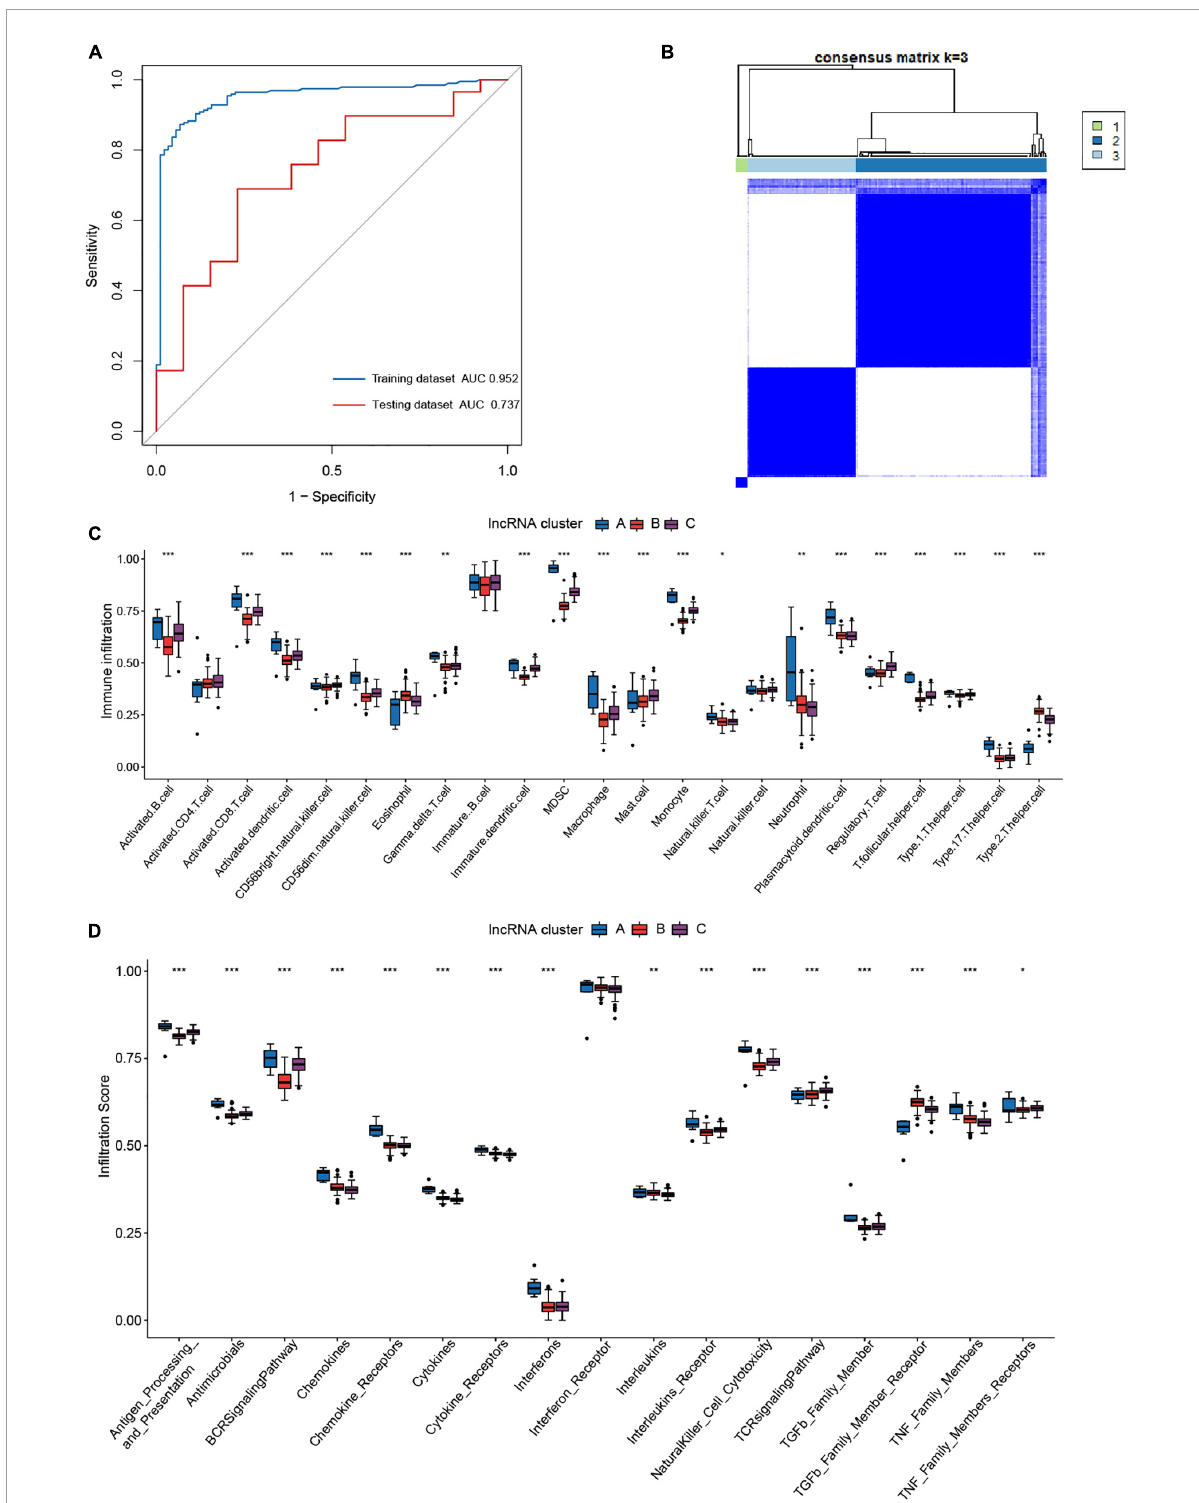
FIGURE8 The role of m 6 A- and m 5 C-related long non-coding ribonucleic acids (lncRNAs) in juvenile idiopathic arthritis (JIA). (A) The ROC curve of the second diagnostic model constructed with lncRNAs for JIA. (B) Consensus clustering classified JIA into three lncRNA clusters. (C) The discrepancies in the abundance of each infiltrating immunocyte in the three lncRNA clusters. (D) The three clusters exhibit varying degrees of immunological